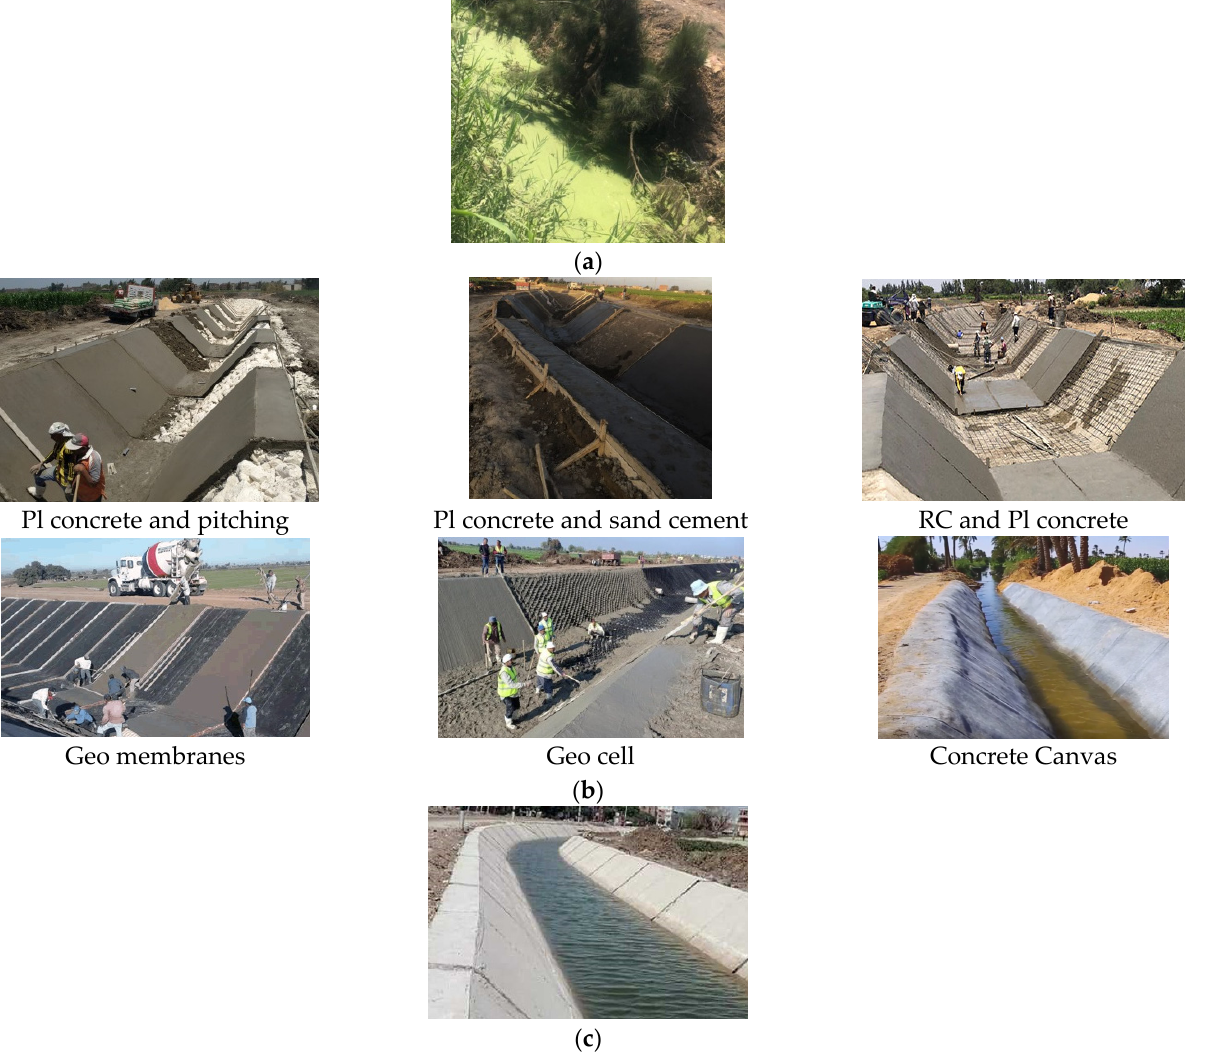
Figure 1. Streams problems and different lining materials. ( a ) Earth canal without lining. ( b ) Different lining types [24, 25, and 26]. ( c ) Irrigation water in lined canals.